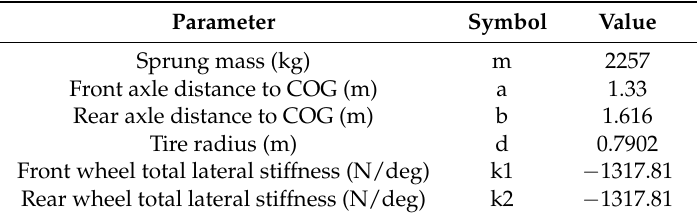
Table 1. Main parameters of